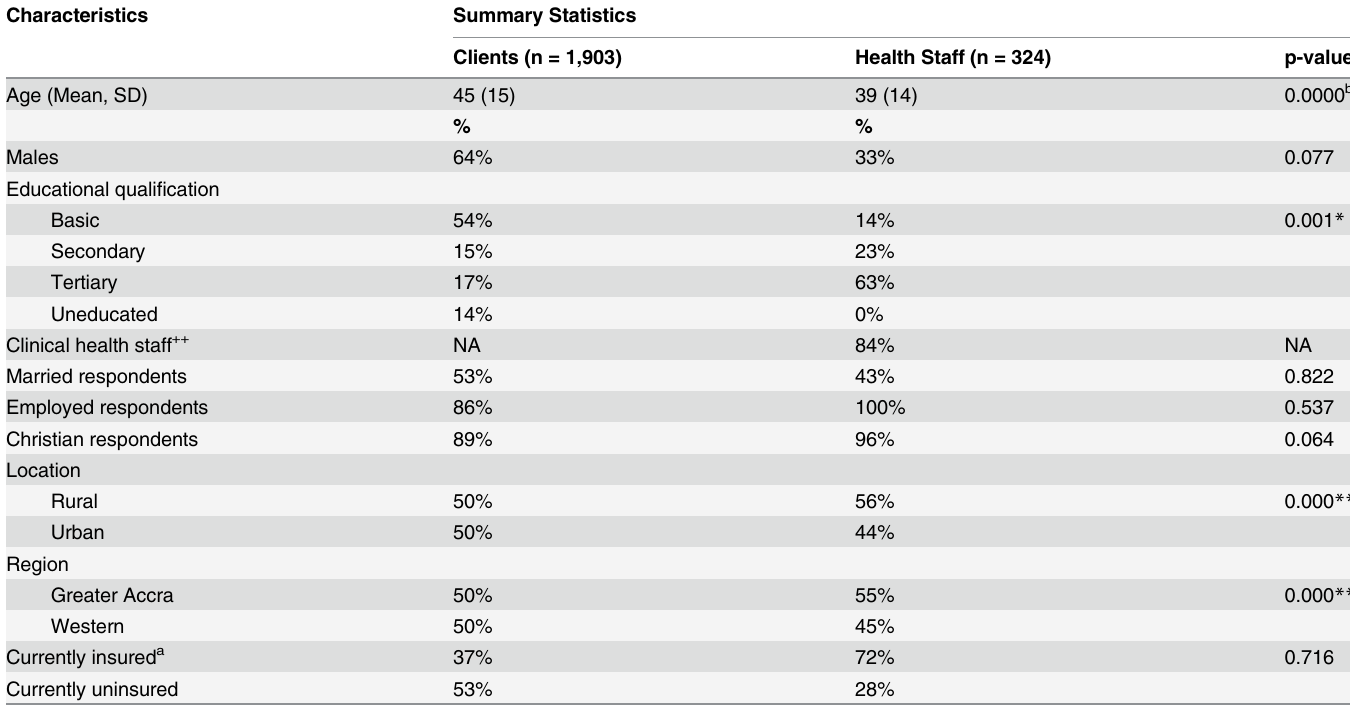
Table 1. Socio-demographic characteristics of clients and health